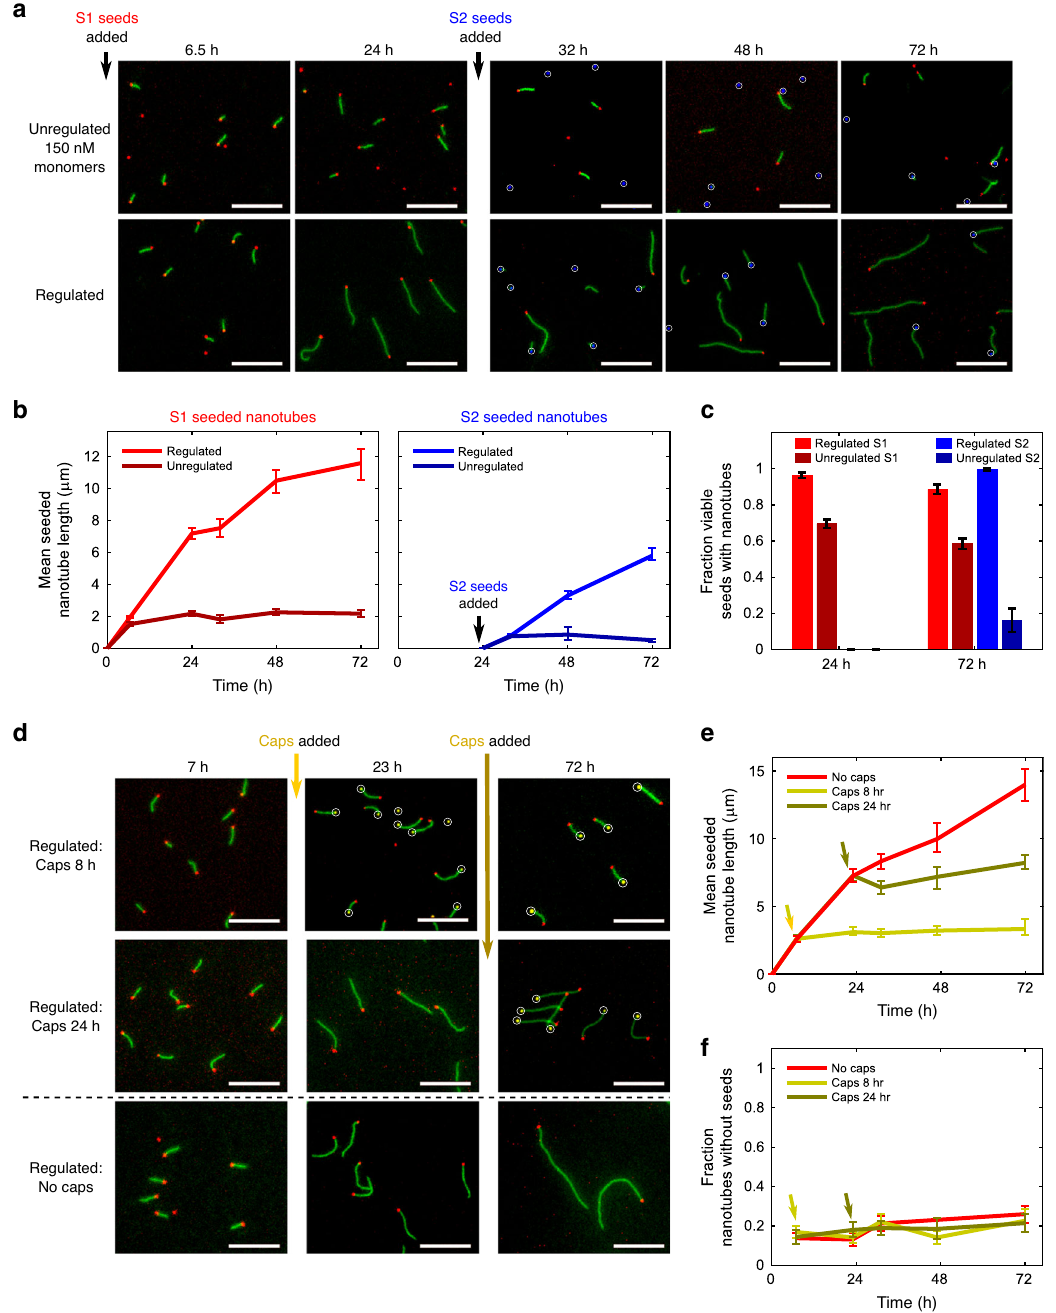
Fig. 6 Feedback regulation maintains growth within the seeded growth regime even as load changes during growth. a Fluorescence micrographs of seeded nanotubes during unregulated (top panel) or buffer-regulated (bottom panel) growth where 0.075nM viable S1 seeds (red) were added at the beginning of the experiment and 0.075 nM viable S2 seeds (blue) were added after 24 h (increasing the load). S1 and S2 seeds differ only in their fl uorescent labels. S2 seeds are circled in white for clarity. b Mean lengths of S1- and S2-seeded nanotubes during regulated and unregulated growth with a load increase. Error bars represent 95% con fi dence intervals from bootstrapping. c Fractions of S1 and S2 seeds with attached nanotubes during regulated and unregulated growth. Error bars on proportions represent 95% con fi dence intervals. d Fluorescence micrographs of seeded nanotubes during buffer- regulated growth with DNA origami caps added (0.2 nM) after either 8 (top panel) or 24 h (middle panel) to remove load. Caps are shown in yellow and circled in white for clarity. e Mean lengths of seeded nanotubes during buffer-regulated growth with and without load removal for the samples in d . Error bars represent 95% con fi dence intervals from bootstrapping. f Fractions of nanotubes not attached to seeds during buffer-regulated growth with and without the addition of caps. Error bars on proportions represent 95% con fi dence intervals. The 15 – 20% of nanotubes without seeds in all samples at all timepoints is likely the result of homogeneous nanotube nucleation. This level of background unseeded growth is consistent with other experiments for regulated and unregulated growth with 150 nM monomers (Supplementary Fig. 19). The sample sizes for every timepoint of each sample are tabulated in Supplementary Note 14. Unregulated growth reactions used 150 nM monomers. Regulated growth experiments were conducted with [ I i ] o = [ P i ] o = 5.5 µ M and [ C i ] o = 1.25 µ M for both monomer types. All scale bars: 10 µ